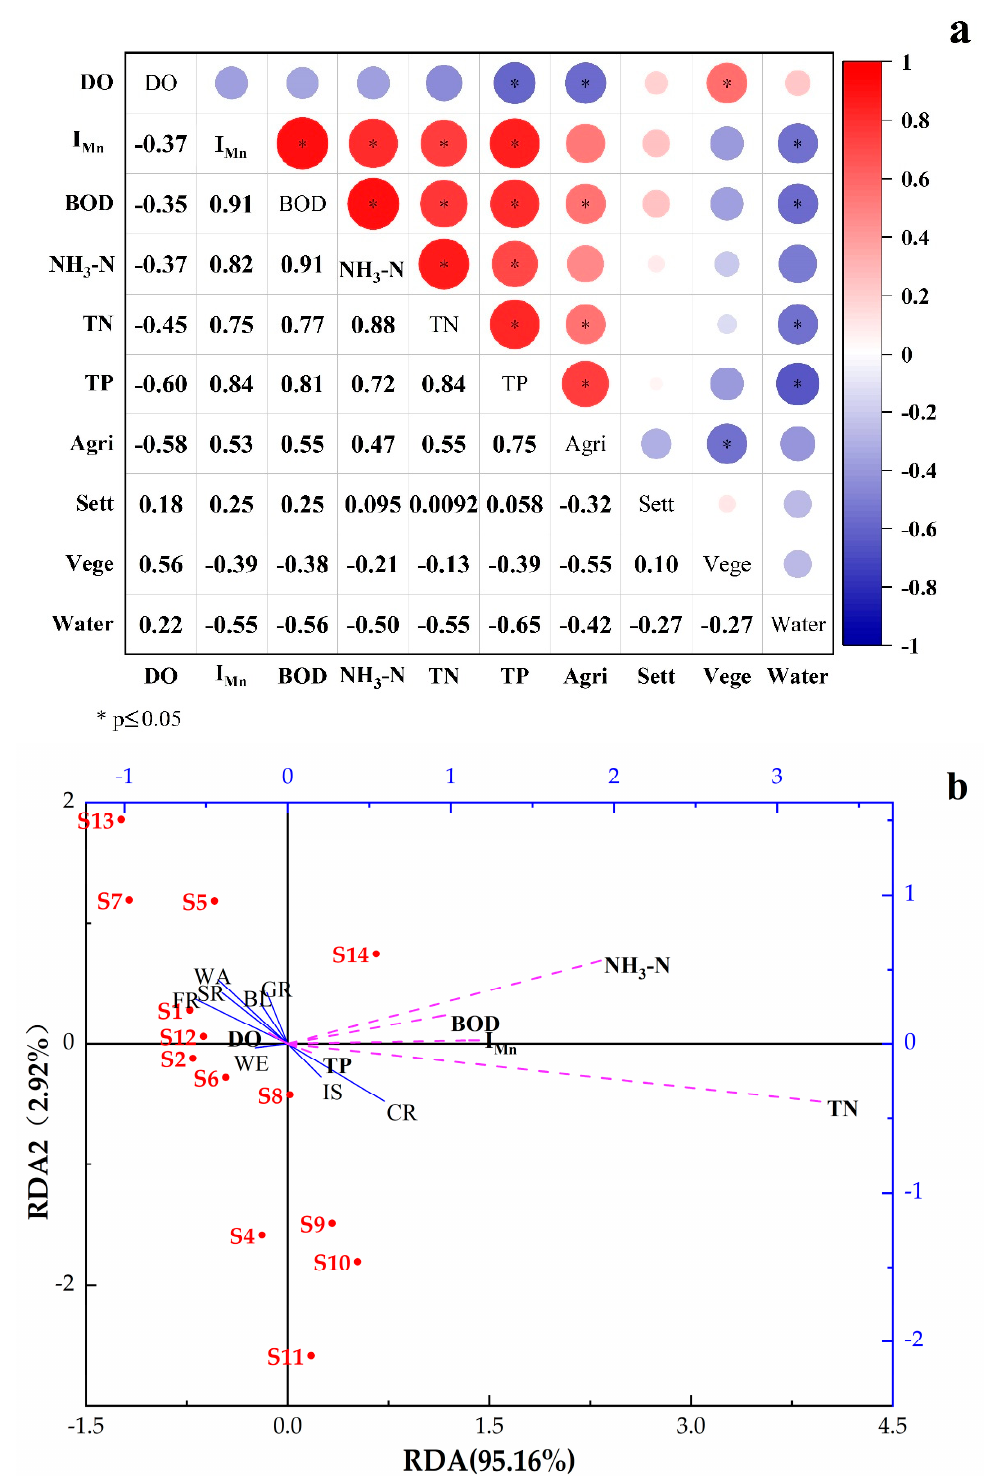
Figure 6. ( a ) Correlation analysis results and the relationships between land use types and water quality indicators, ( b ) redundancy analysis of the relationships between land use types and water quality indicators.